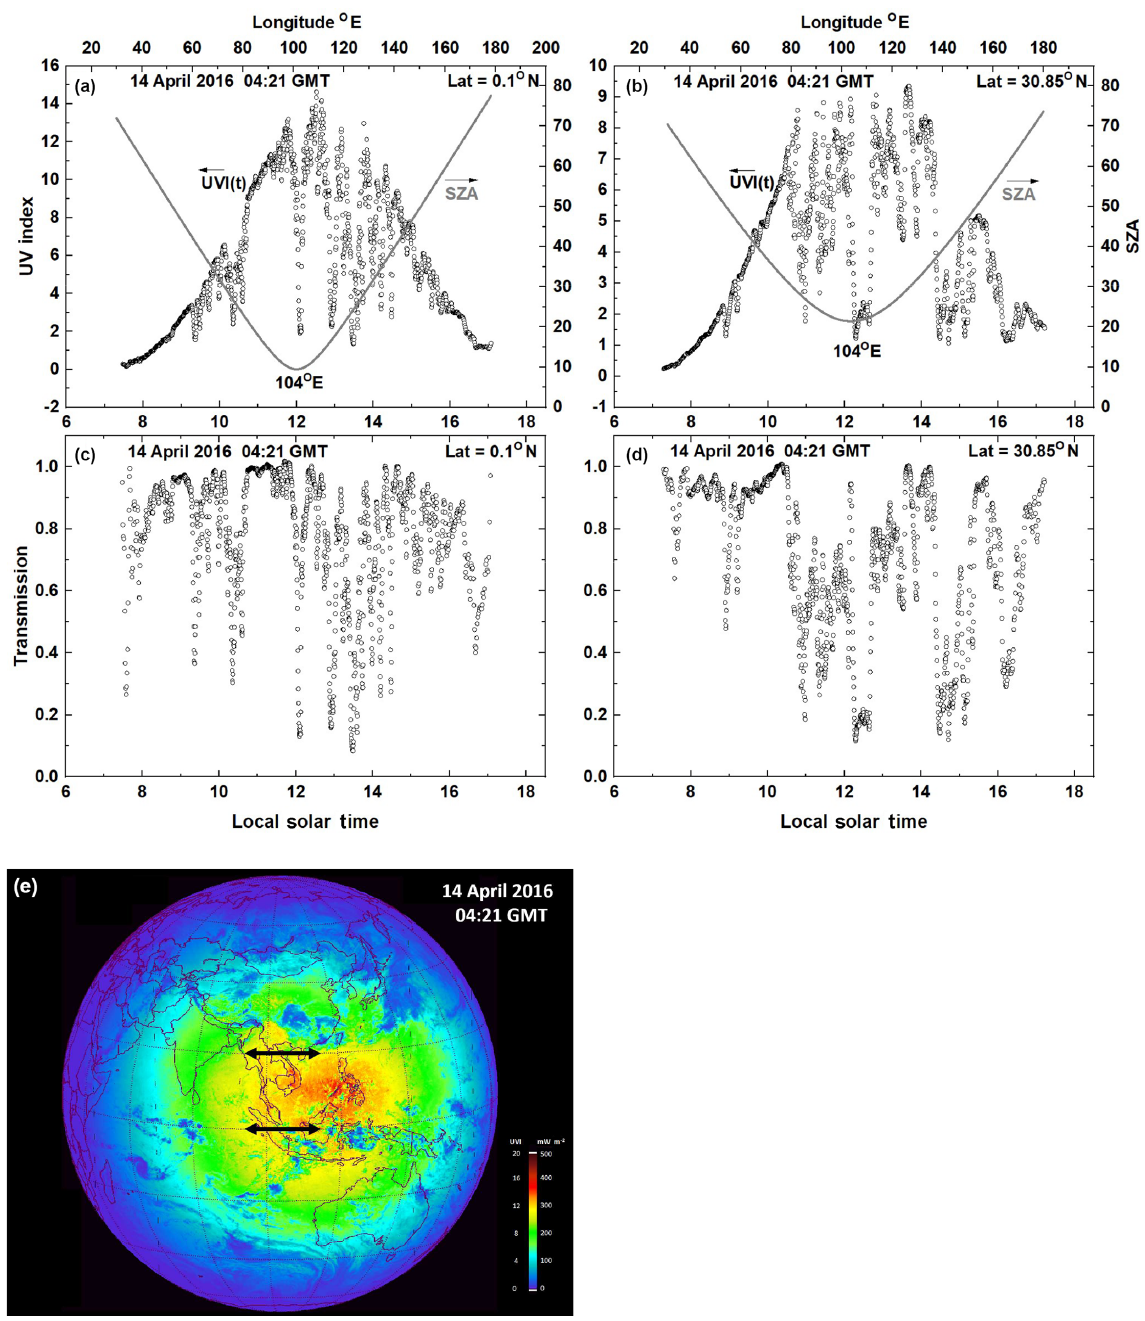
Figure 15. Longitudinal slices of UVI( ζ,ϕ,t O ) at 0.1 and 30.85 ◦ N latitude (short dark horizontal arrows in e ). The EPIC E(ζ,ϕ,t O ) (mWm − 2 ) images are for 14 April 2016 t O = 04:21GMT centered at about 10 ◦ N and 104 ◦ E. (a, c) show longitudinal slices of E(ζ,ϕ,t O ) and C T (ζ,ϕ,t O ) for ζ = 0 . 1 ◦ N and (b, d) for 30.85 ◦ N. The solid lines in (a, b) represent the SZA. Figure map created with IDL ®